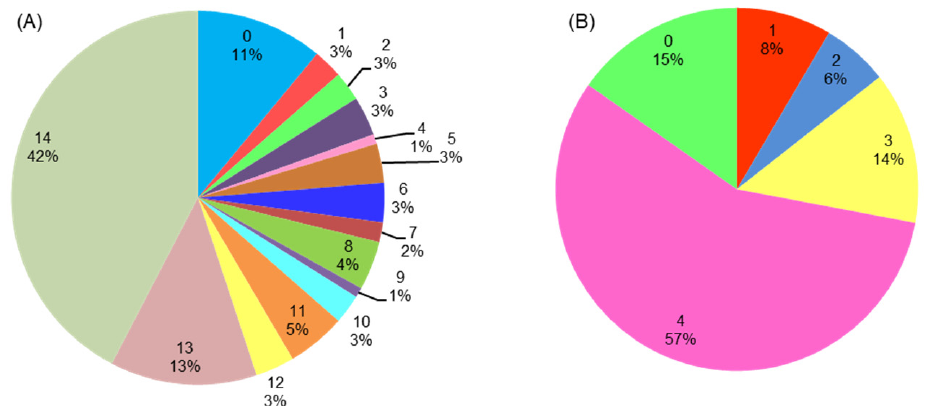
Figure 6. Expression of the PgWRKY in ginseng. ( A ) Expression of the PgWRKY in different tissues of ginseng. ( B ) Expression of the PgWRKYs in different 4 different-aged roots. The percentages of each part of the pie indicates the percentage of the 118 PgWRKYs ; the number behind the percentage in each part of the pie indicates the number of ( A ) the 14 tissues ( B ) or the number of 4 year-olds roots